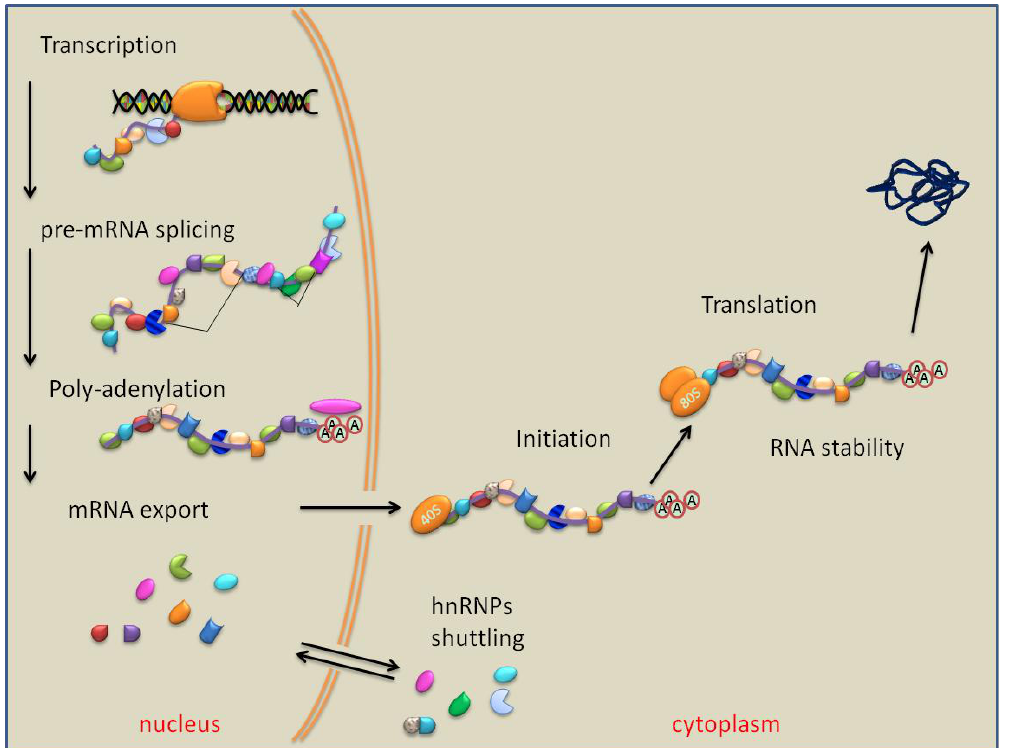
Figure 1. RNA binding proteins are involved in all steps of RNA biogenesis. Starting from pre-mRNA transcript synthesis, a variety of different RNA binding proteins are associated within the heterogeneous ribonucleoprotein complexes, participating in the processes which result in the formation of mature mRNA, including pre-mRNA splicing and addition of 3' poly(A) tails in the nucleus and mRNA export through the nuclear pores. In the cytoplasm, they participate in localization, initiation of translation, and mRNA